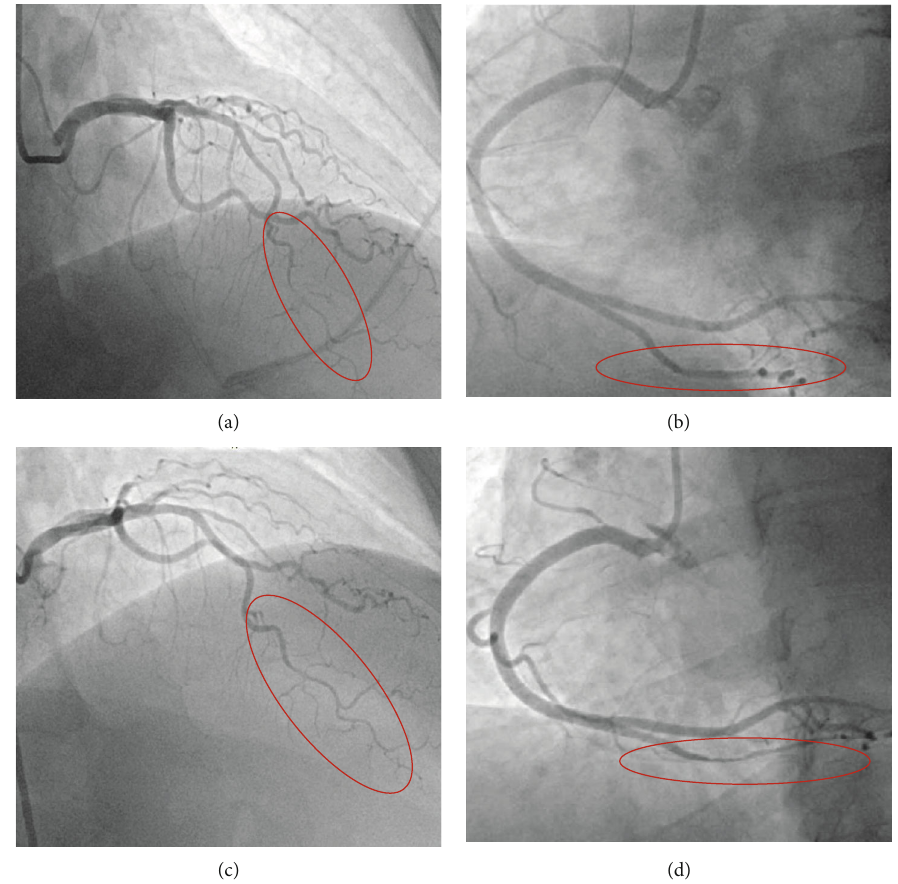
Figure 2: Frame A: initial angiogram showing Type 2 SCAD, with a long segment of di ff use vessel narrowing in the mid to distal LAD. Frame B: initial angiogram showing the PDA with no angiographic disease or narrowing. Frame C: repeat angiogram on hospital day 6 showing healing of initial SCAD lesion after medical therapy. Frame D: repeat angiogram showing new Type 2 SCAD lesion in the